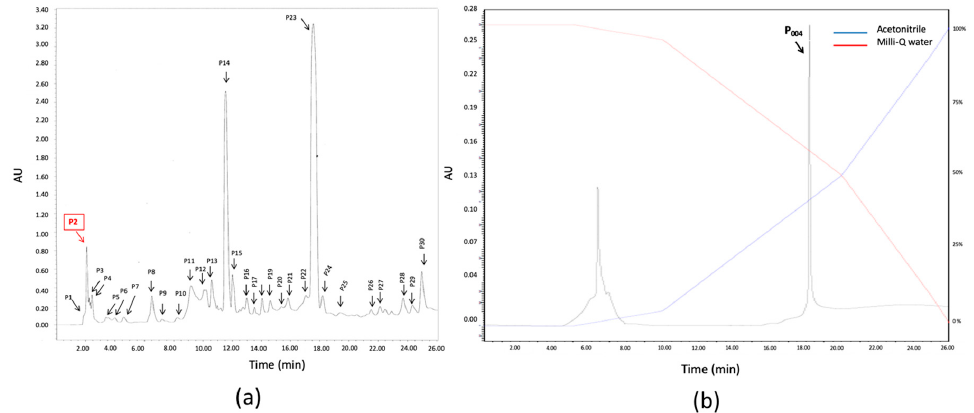
Figure 6. Reverse-phase-high-performance liquid chromatography (RP-HPLC) elution profile of the SN IIIA004 active fraction ( a ) chromatographic profile of the 20% acetonitrile anti-biofilm fraction eluted by solid-phase extraction on HyperSep C 18 cartridges of SN IIIA004 . Only one fraction, P2 (2nd pic), presented anti-biofilm activity. ( b ) Chromatographic profile of the P2 fraction eluted by the first RP-HPLC separation. Eluents were Milli-Q water and acetonitrile.